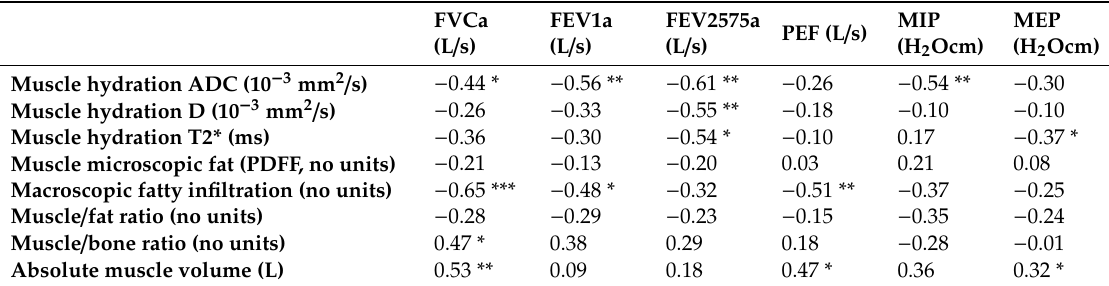
Table 5. Statistically significant correlations between imaging biomarkers and respiratory parameters with | r | >